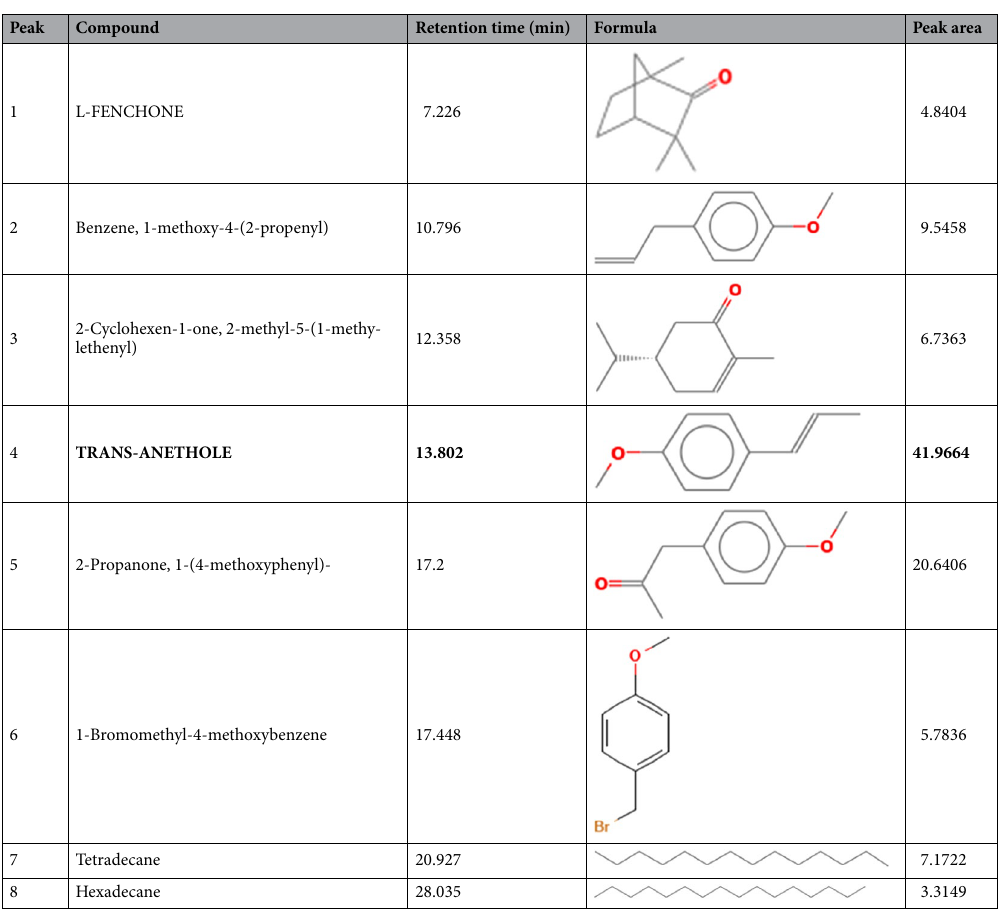
Table 1. Descriptors of the volatile components detected by GC–MS. Significant values are in